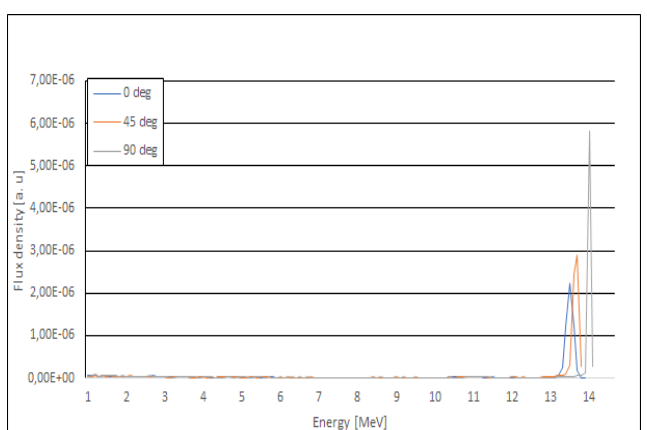
Figure 6. Simulated neutron spectra of the VSB neutron generator for various emission angles